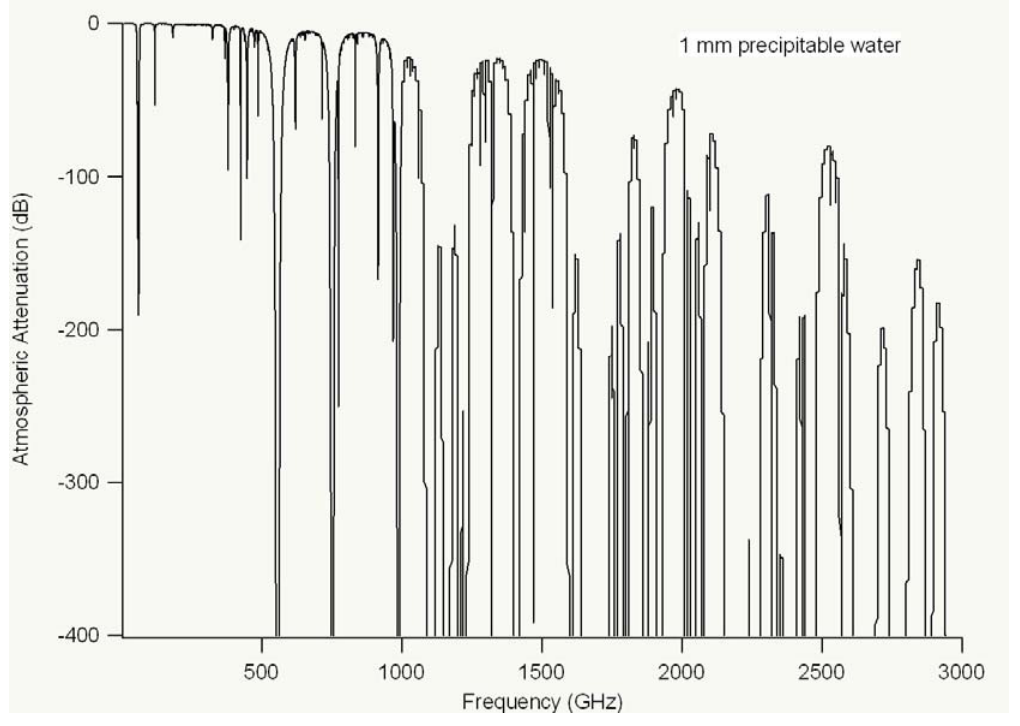
Figure 15. Atmospheric attenuation (in dB) of 1 mm precipitable water from 10 GHz to